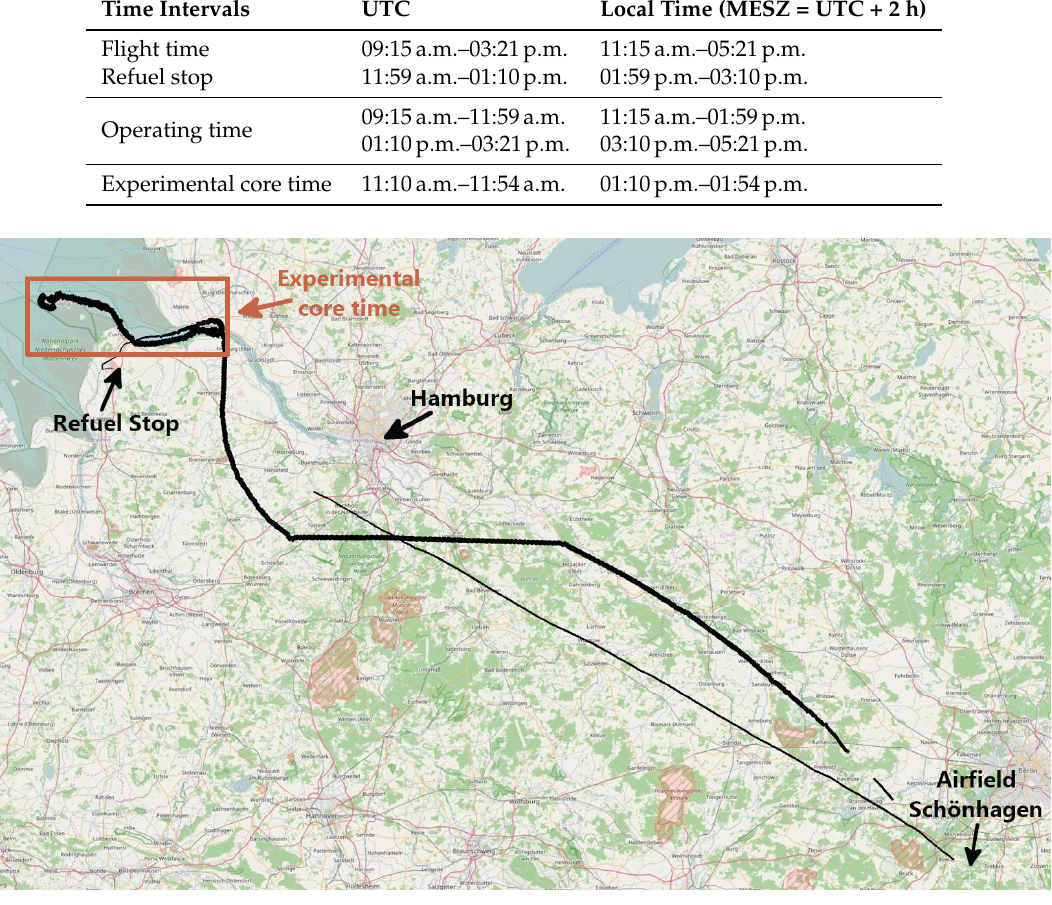
Figure 6. Flight path from the airfield Schönhagen to the North Sea and